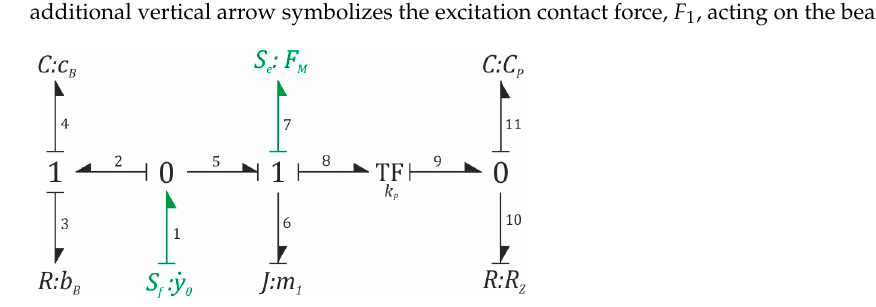
Figure 2. A graph of bonds representing the dynamics of the tested design solutions of energy harvesting systems.